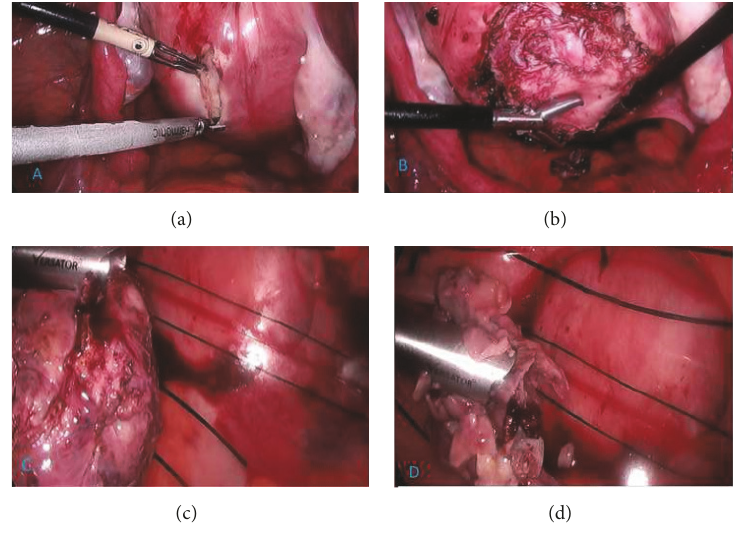
Figure 3: (a, b, c, d) Laparoscopic morcellation of fibroid in isolated bag.